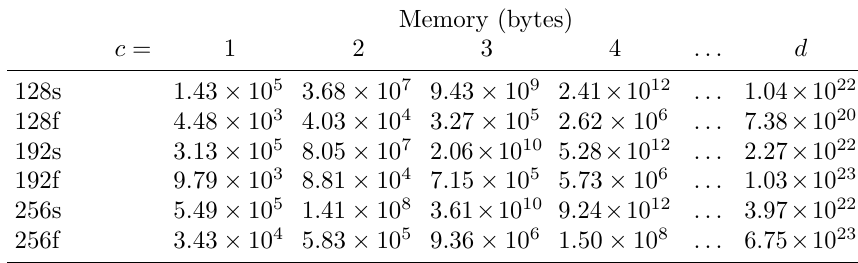
Table 10: Analysis of the layer caching countermeasure for all SPHINCS + parameter sets. Memory